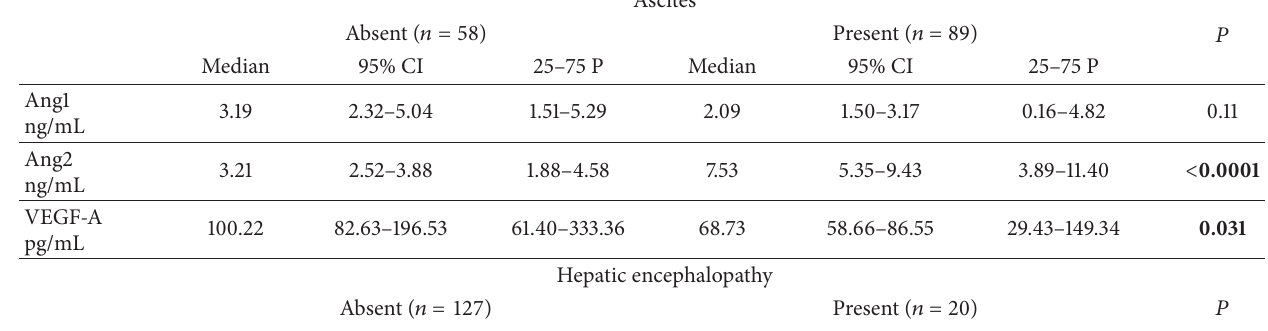
Table 5: Plasma angiogenesis-related biomarkers in subgroups of ALD patients according to the presence of the disease complications.